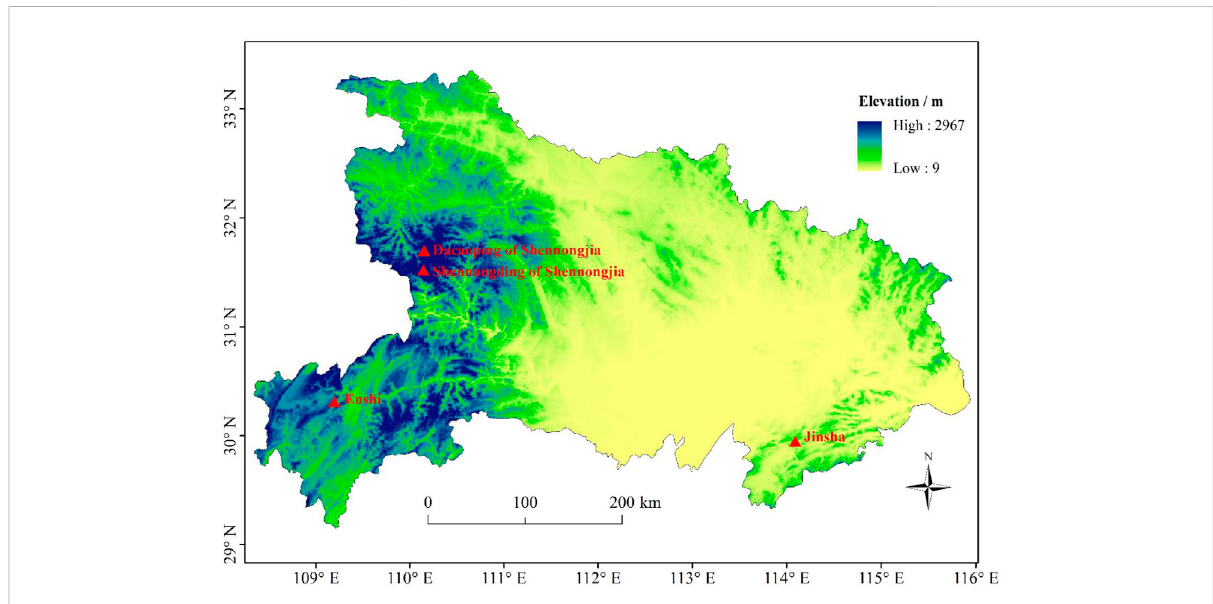
FIGURE 1 Map of study area and distribution of observation sites of wire icing (red triangles) in Hubei in the winter of 2008 – 2009 and 2012 –